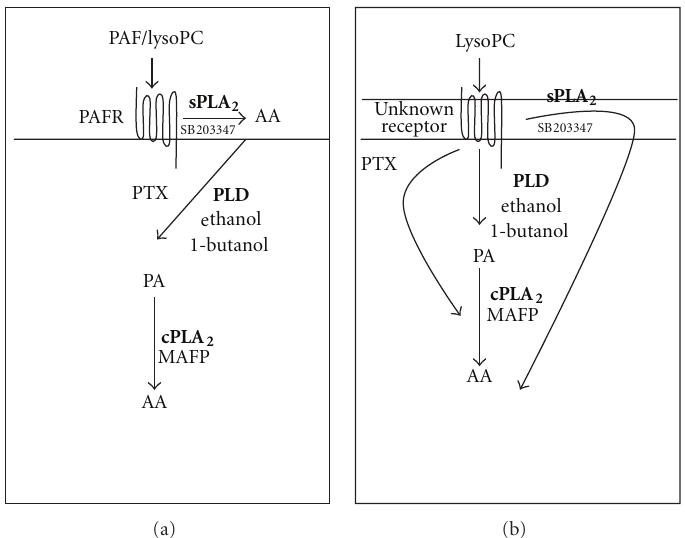
Figure 7: Proposed main molecular mechanisms of intracellular signaling mediated by (a) PAF receptor and (b) unidentified lysoPC- sensitive receptor. The figure shows enzymes in bold/italic and inhibitors in small letters with the sign “– |